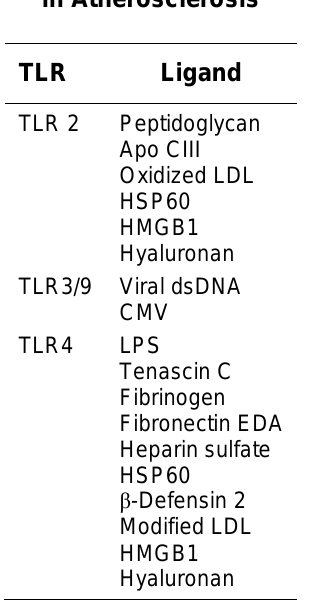
TLR Ligands Implicated in